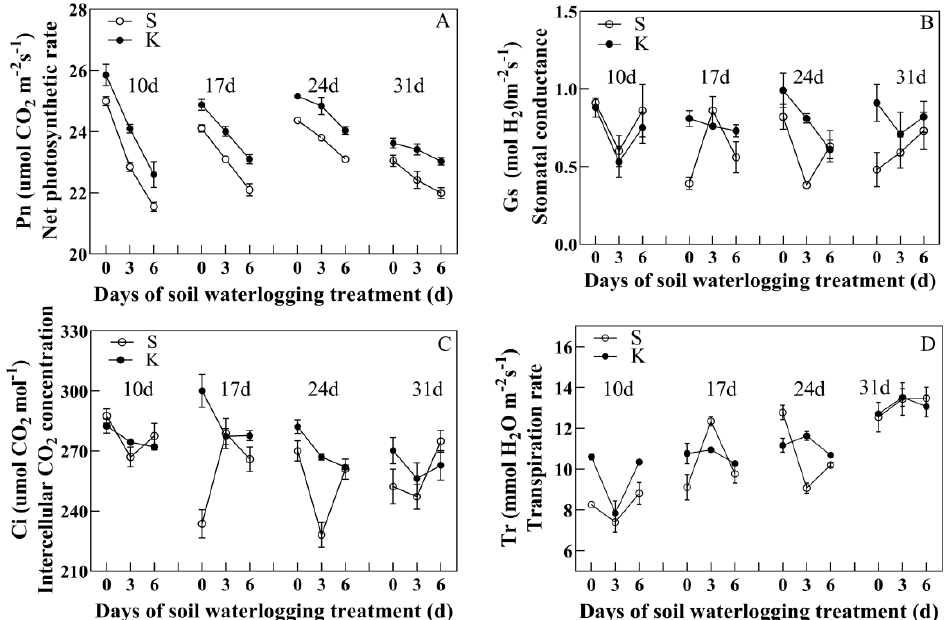
Figure 2. Effect of potassium application on gas exchange parameters (( A ) net photosynthetic rate; ( B ) stomatal conductance; ( C ) intercellular CO 2 concentration; ( D ) transpiration rate) in cotton leaves under soil waterlogging stress. S represents the soil waterlogging without potassium treatment groups. K represents the soil waterlogging with potassium treatment groups; 0, 3, 6 in X − coordinate represent the duration days of soil waterlogging treatment and 10 d, 17 d, 24 d, 31 d represent the gas exchange measurement days after soil waterlogging.